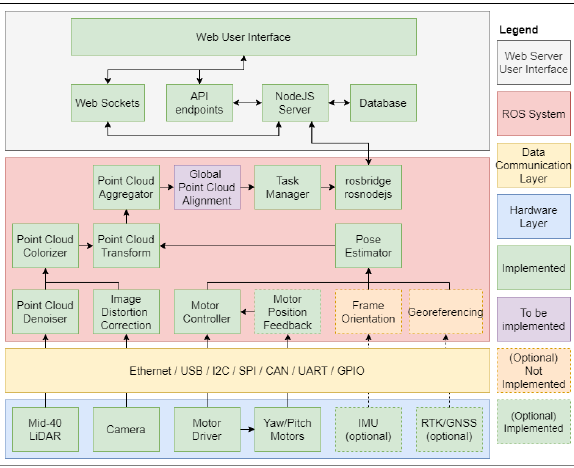
Figure 5. System pipeline overview diagram